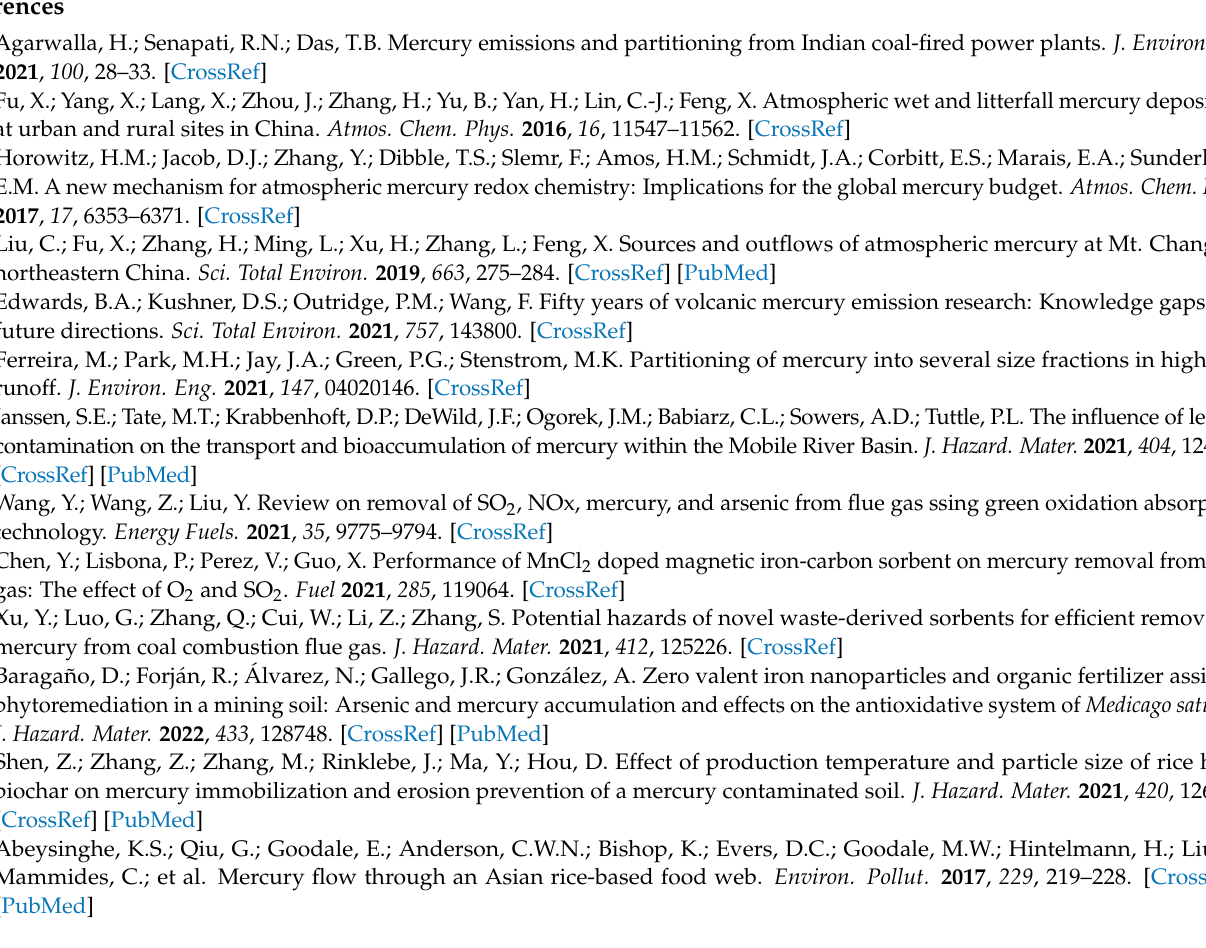
Table S6: Results of the general linear mixed models on Sobs, Shannon, and Shannoneven index of AMF communities; Table S7: Pearson correlations between soil properties and arbuscular mycorrhizal fungi (AMF) richness and diversity using canonical correspondence